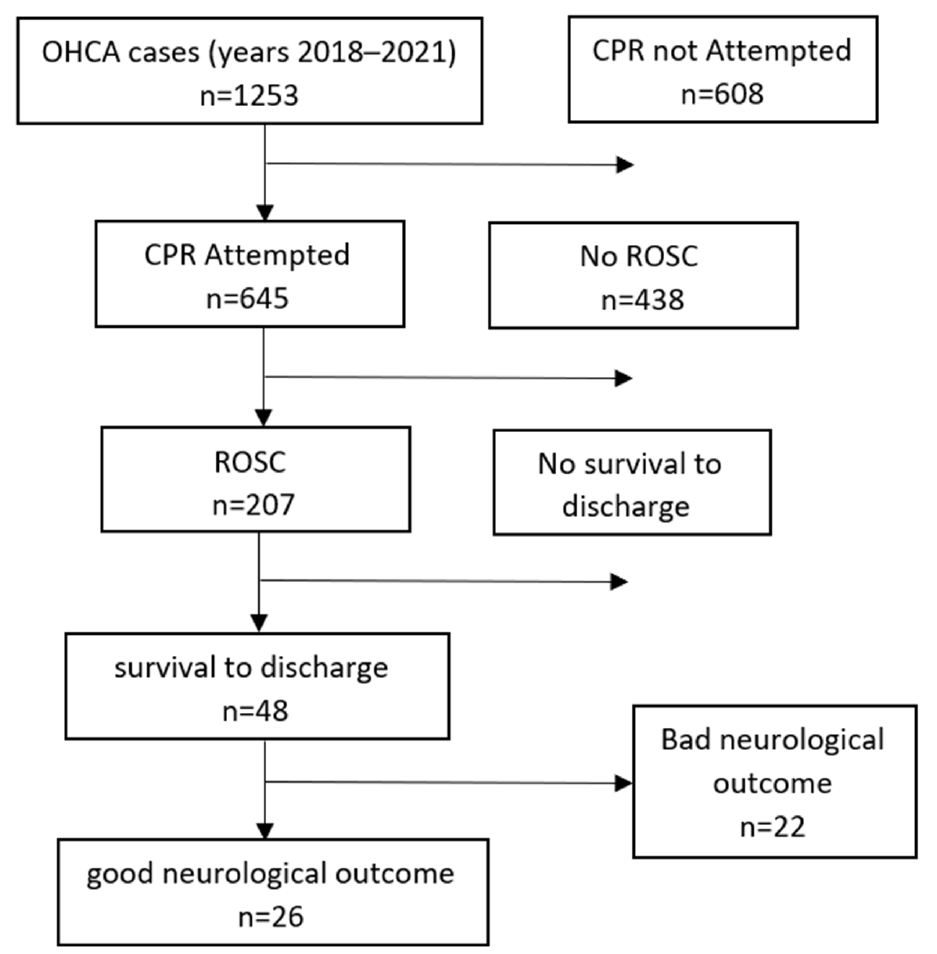
Figure 1. Study flow chart.